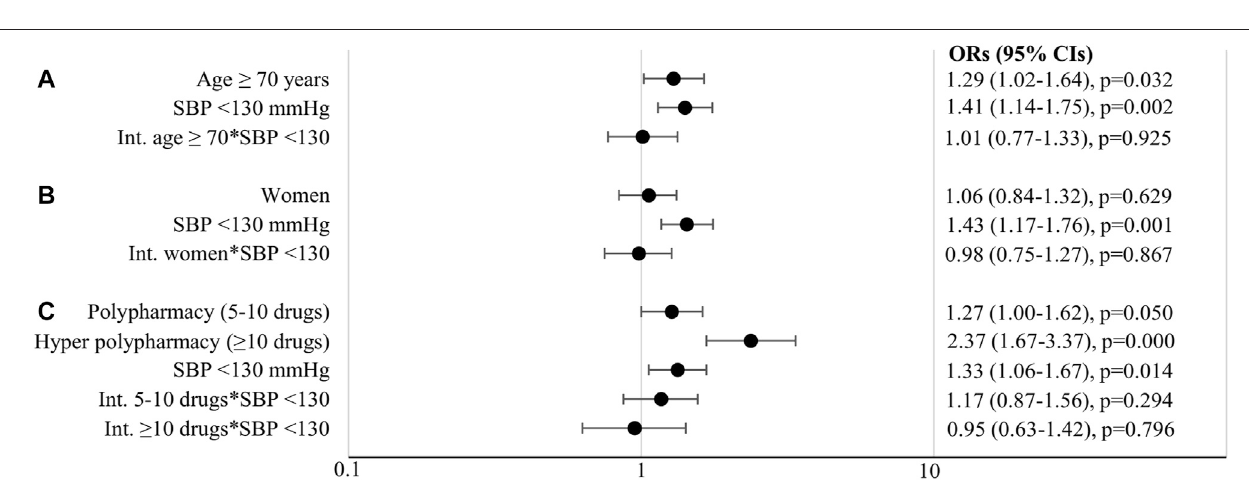
Frontiers in Pharmacology |